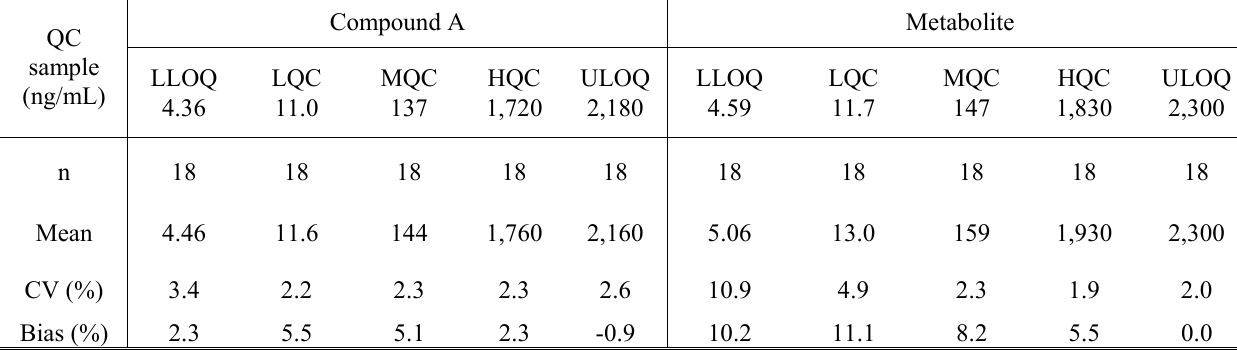
Table 1. Inter-day accuracy and precision of the LLOQ, low QC (LQC), mid QC (MQC), high QC (HQC), and ULOQ evaluation samples for rat whole blood method. Mean values in the table are the average of the back-calculated concentrations from the standard